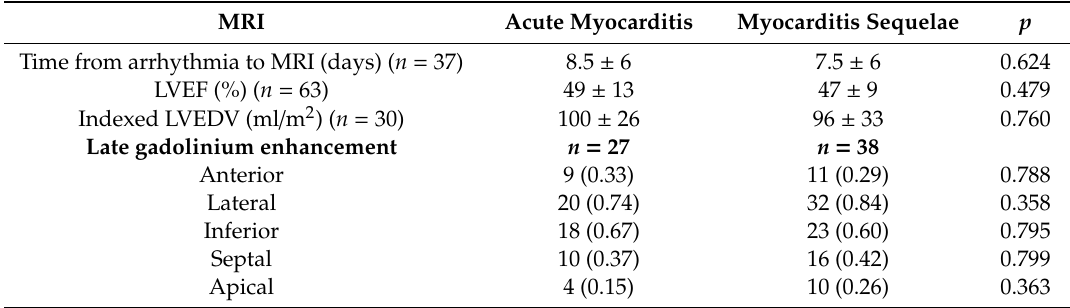
Table 4. Myocardial magnetic resonance imaging (MRI) data. LVEF: left ventricular ejection fraction, LVEDV: left ventricular end-diastolic volume. MRI Acute Myocarditis Myocarditis Sequelae p Time from arrhythmia to MRI (days) ( n =